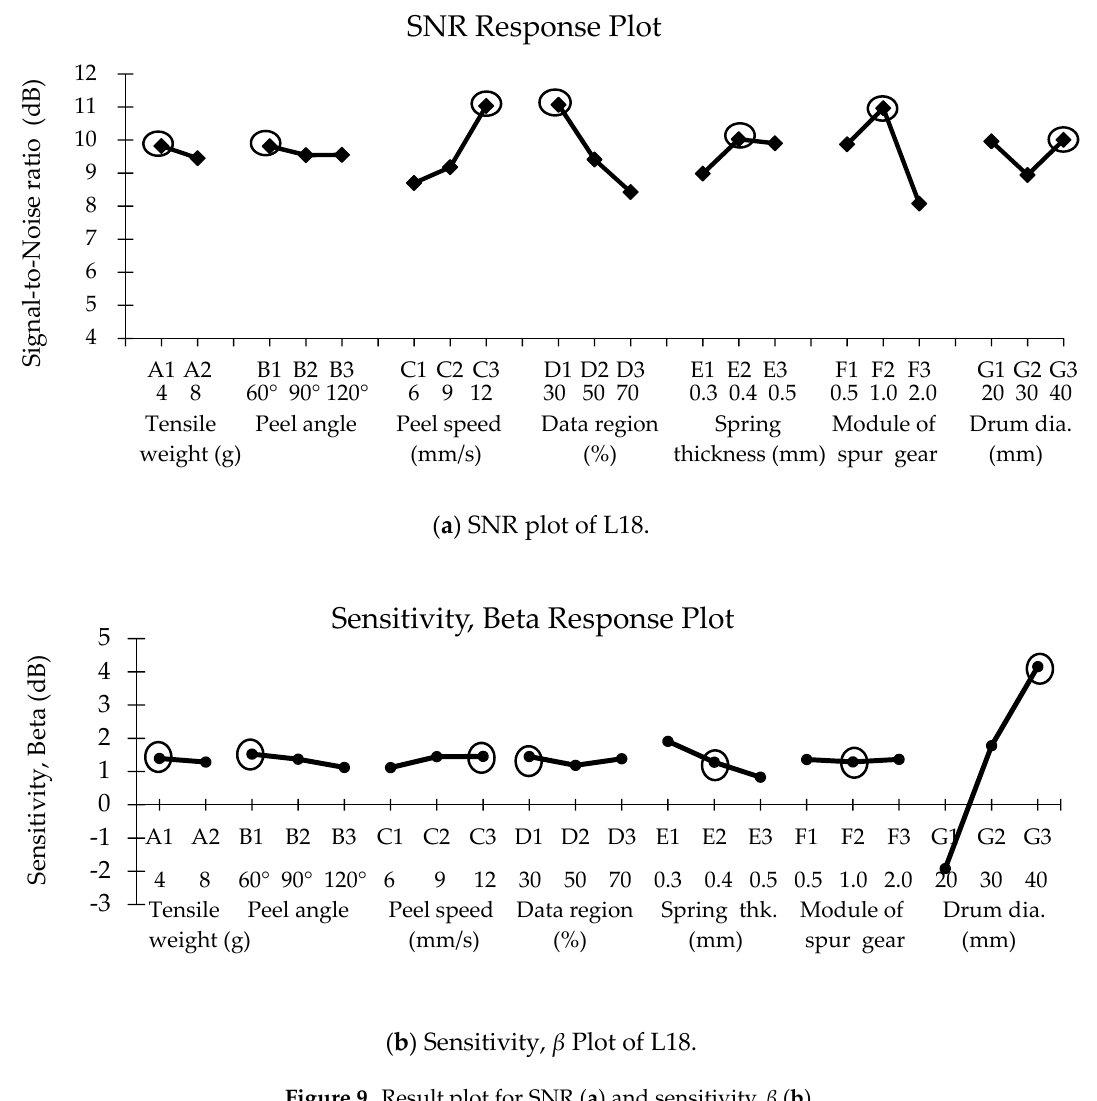
( b ) Sensitivity, β Plot of L18. Figure 9. Result plot for SNR ( a ) and sensitivity, β ( b ). Figure 9. Result plot for SNR ( a ) and sensitivity, β ( b